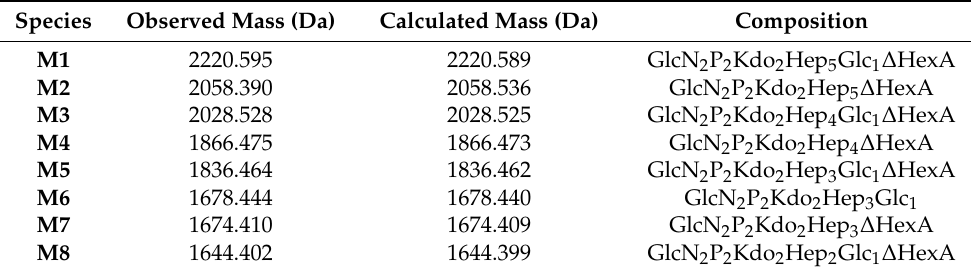
Figure 1. Charge deconvoluted ElectroSpray Ionization Fourier Transform-Ion Cyclotron Resonance (ESI FT-ICR) mass spectrum of the totally deacylated lipopolysaccharide (LPS) fraction (L-OS KOH ) isolated from the E. amylowora Ea Δ waaL mutant. The spectrum was acquired in negative ion mode. The mass numbers given refer to the monoisotopic peak of the neutral molecular species. Table 1. Composition of the main species observed in the charge deconvoluted ESI FT-ICR mass spectrum of the totally deacylated LPS (L-OS KOH ) from a E. amylowora waaL mutant (Ea ∆